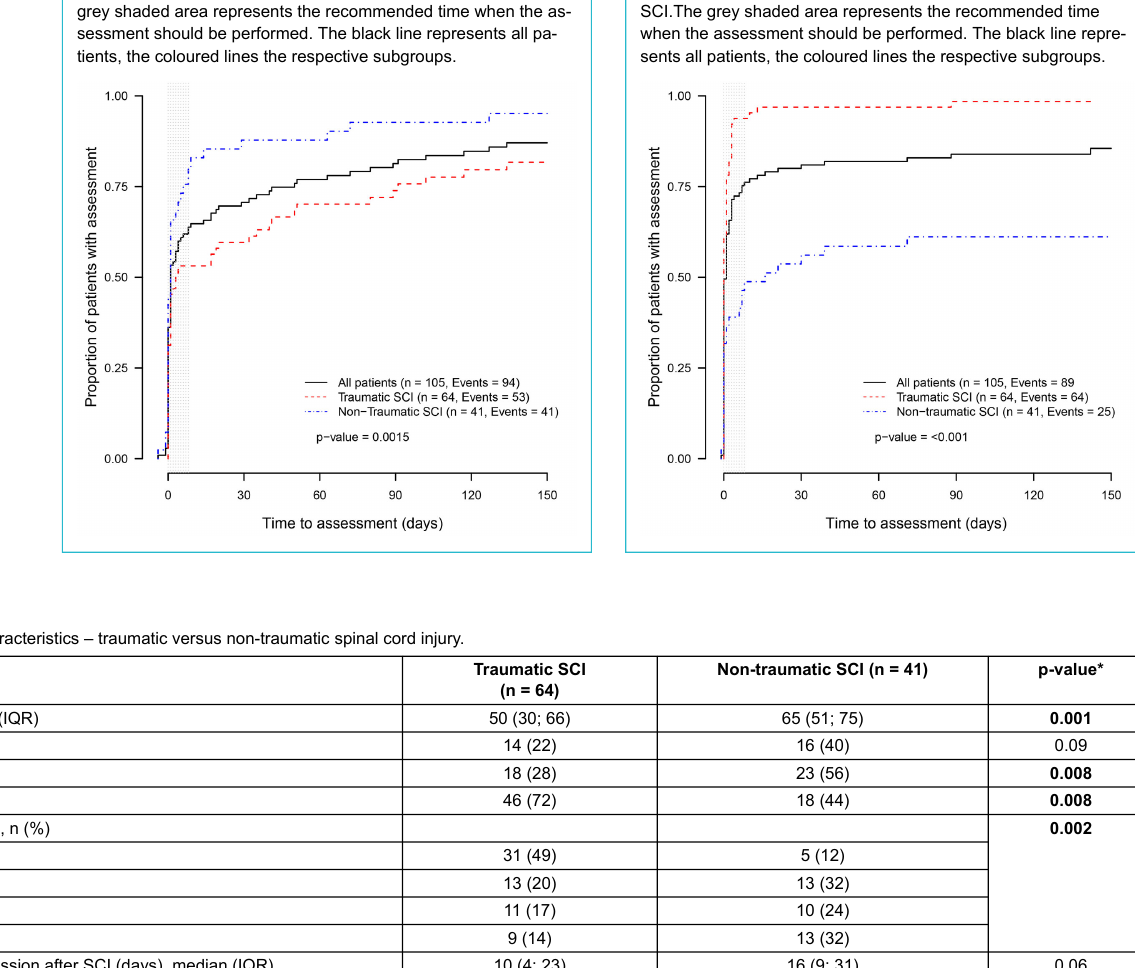
Figure 2: Computed tomography of the spine after spinal cord in- jury (SCI) for patients with a traumatic versus a non-traumatic SCI.The grey shaded area represents the recommended time when the assessment should be performed. The black line repre- sents all patients, the coloured lines the respective subgroups.